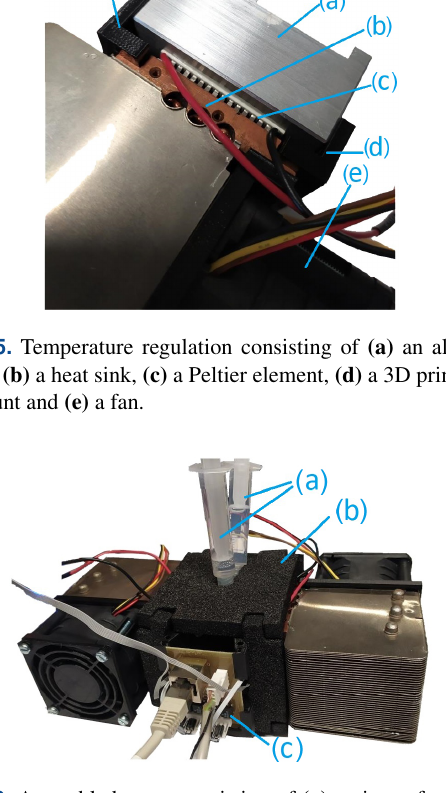
Figure 6. Assembled setup consisting of (a) syringes for fluid in- jection, (b) thermal insulation and (c) a